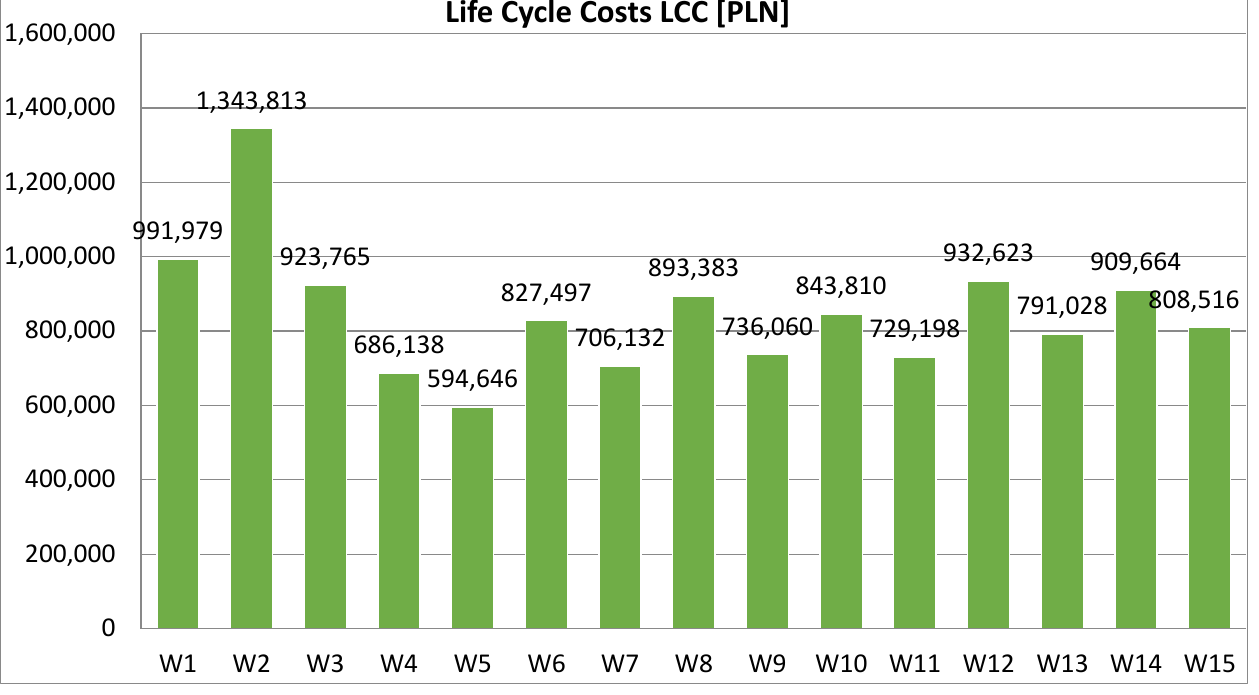
Scheme 13. Comparison of life cycle costs for buildings supplied from various energy sources and